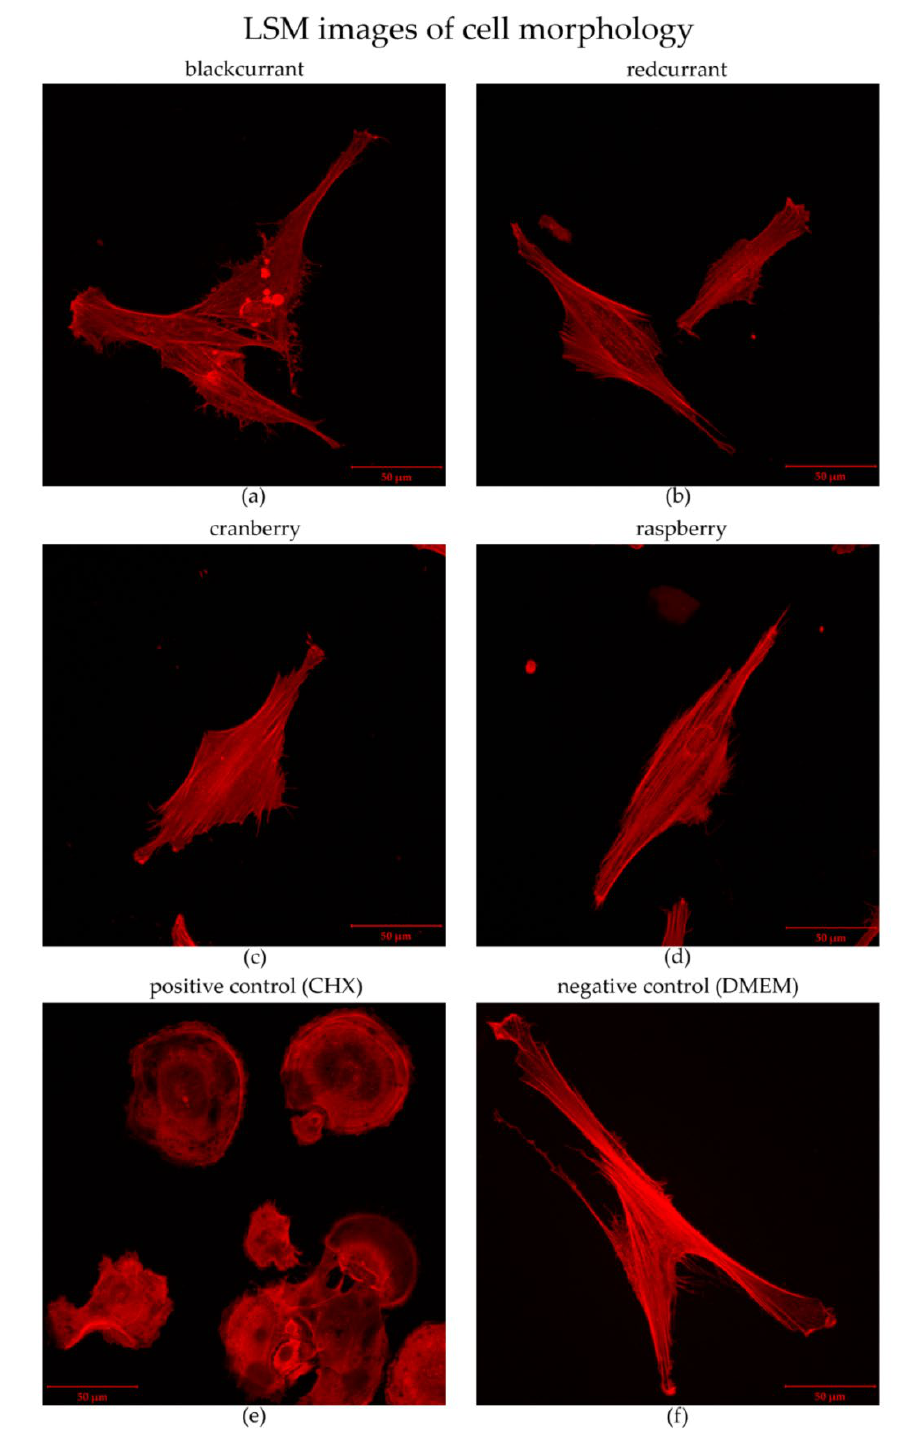
Figure 5. Morphology of human gingival fibroblasts (hGF) observed by laser scanning microscopy after direct contact with the respective test agent. Actin filaments were stained with phalloidine-rhodamine. ( a ) Blackcurrant; ( b ) redcurrant; ( c ) granberry; ( d ) raspberry; ( e ) positive control (0.2% CHX); ( f ) negative control (DMEM).